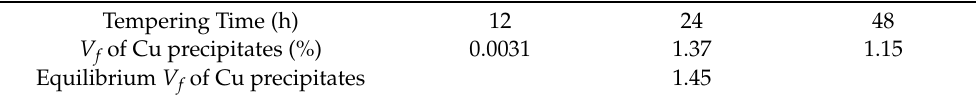
Table 6. Estimated volume fraction of Cu precipitates and volume fraction of Cu precipitates according to JMatPro software under equilibrium conditions at 500 ◦